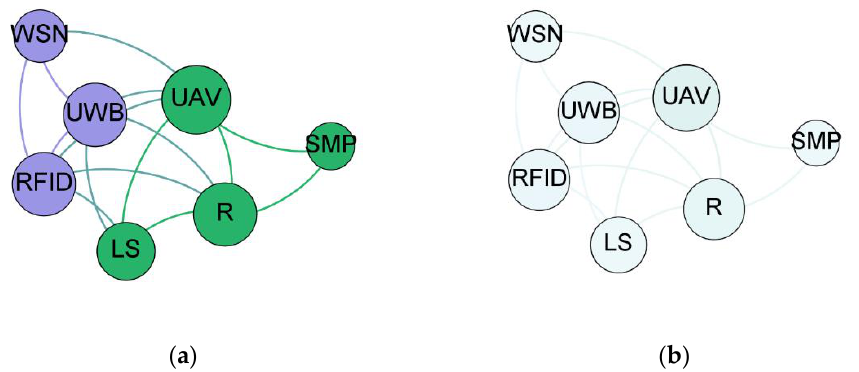
Figure 5. Intra-FDCT network analysis. ( a ) Modularity: capture technologies form two communities. ( b ) Betweenness: UAV stands out subtly; the balance of betweenness between capture technologies is maintained, as represented by the pale green color.